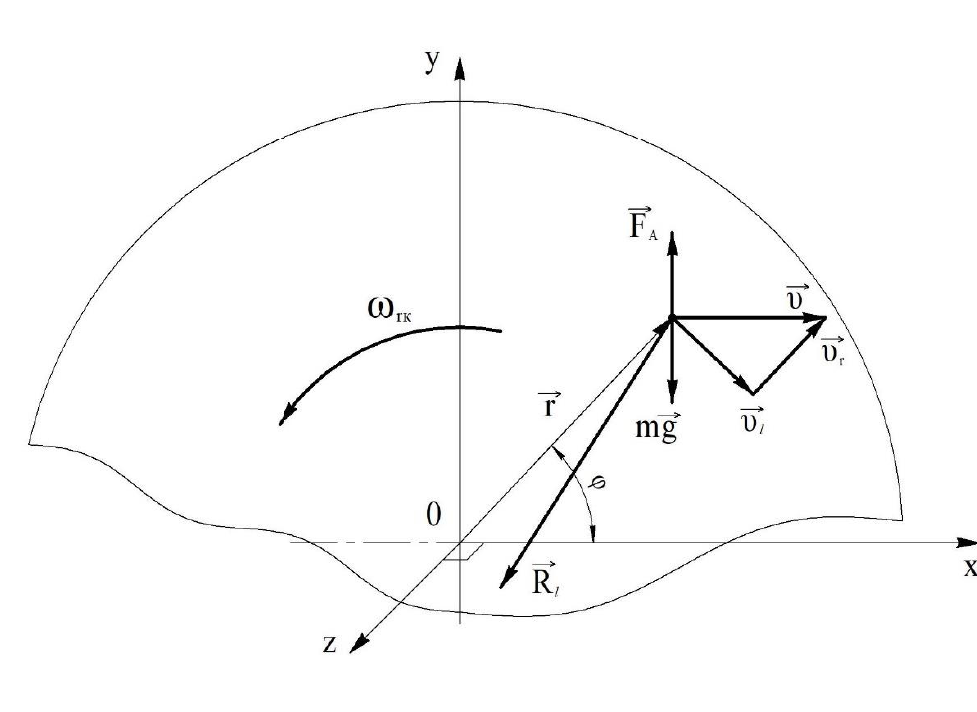
Figure 2. Diagram of external forces acting on a particle in the impeller of the experimental setup .